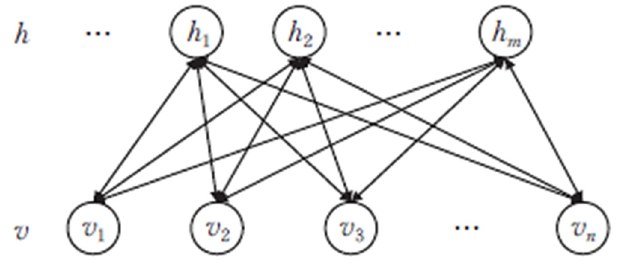
Figure 4. RBM model structure diagram.